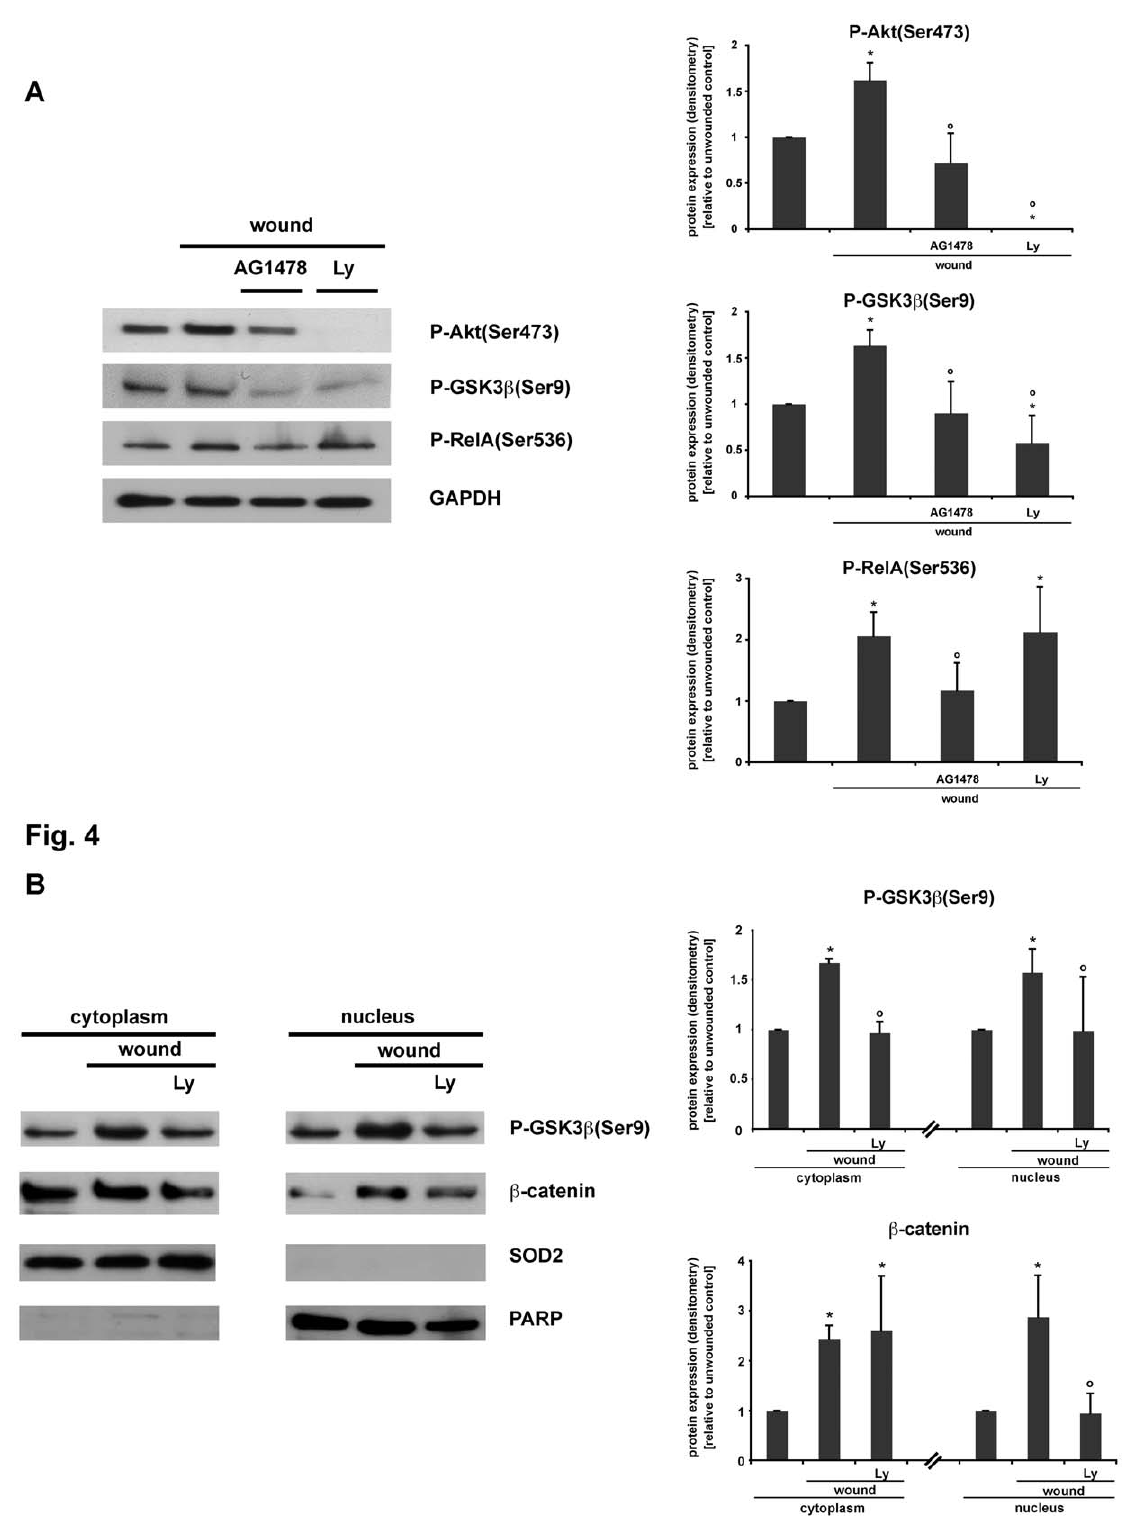
Figure 4. Wounding-induced GSK3ß(Ser9) phosphorylation and ß-catenin nuclear translocation is dependent on PI3K activation. Confluent IEC18 cell monolayers were pretreated for 30 minutes with the specific inhibitors of PI3K activation Ly294002 (25 m M, Ly) and EGF-R autophosphorylation AG1478 (1 m M) or solvent control and then wounded by multiple scraping. (A) Total cell protein extracts were prepared 30 minutes after wounding and analysed via Western blot. Wounding-induced Akt(Ser473)- and GSK3ß(Ser9)-phosphorylation were blocked by Ly294002 as well as reduced by AG1478. As positive control, AG1478 caused inhibition of RelA phosphorylation (indicating NF-kB activation) after wounding is shown [11]. (B) 30 minutes after wounding, cells were lysed, subcellular fractions of nuclear/cytoplasmic protein were prepared and